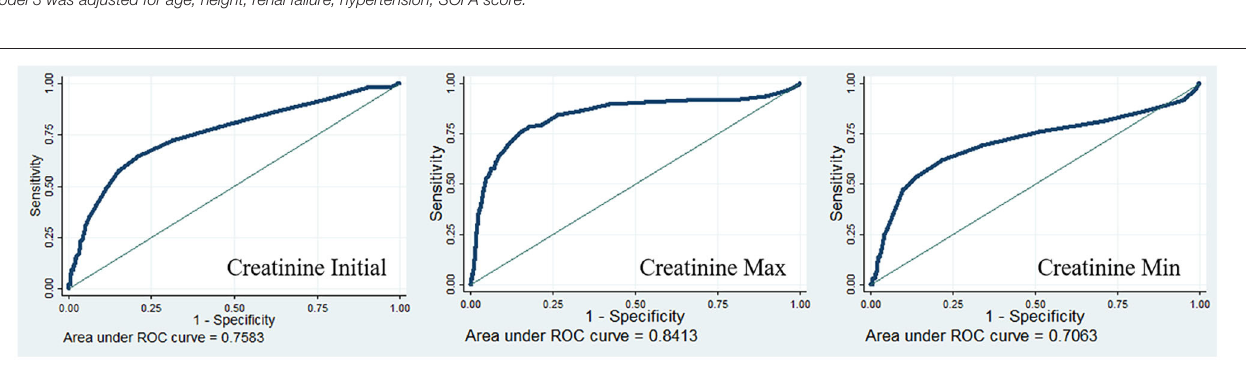
FIGURE 1 | Receiver operating characteristic curves for postoperative serum creatinine in-hospital mortality of the cardiac patients.